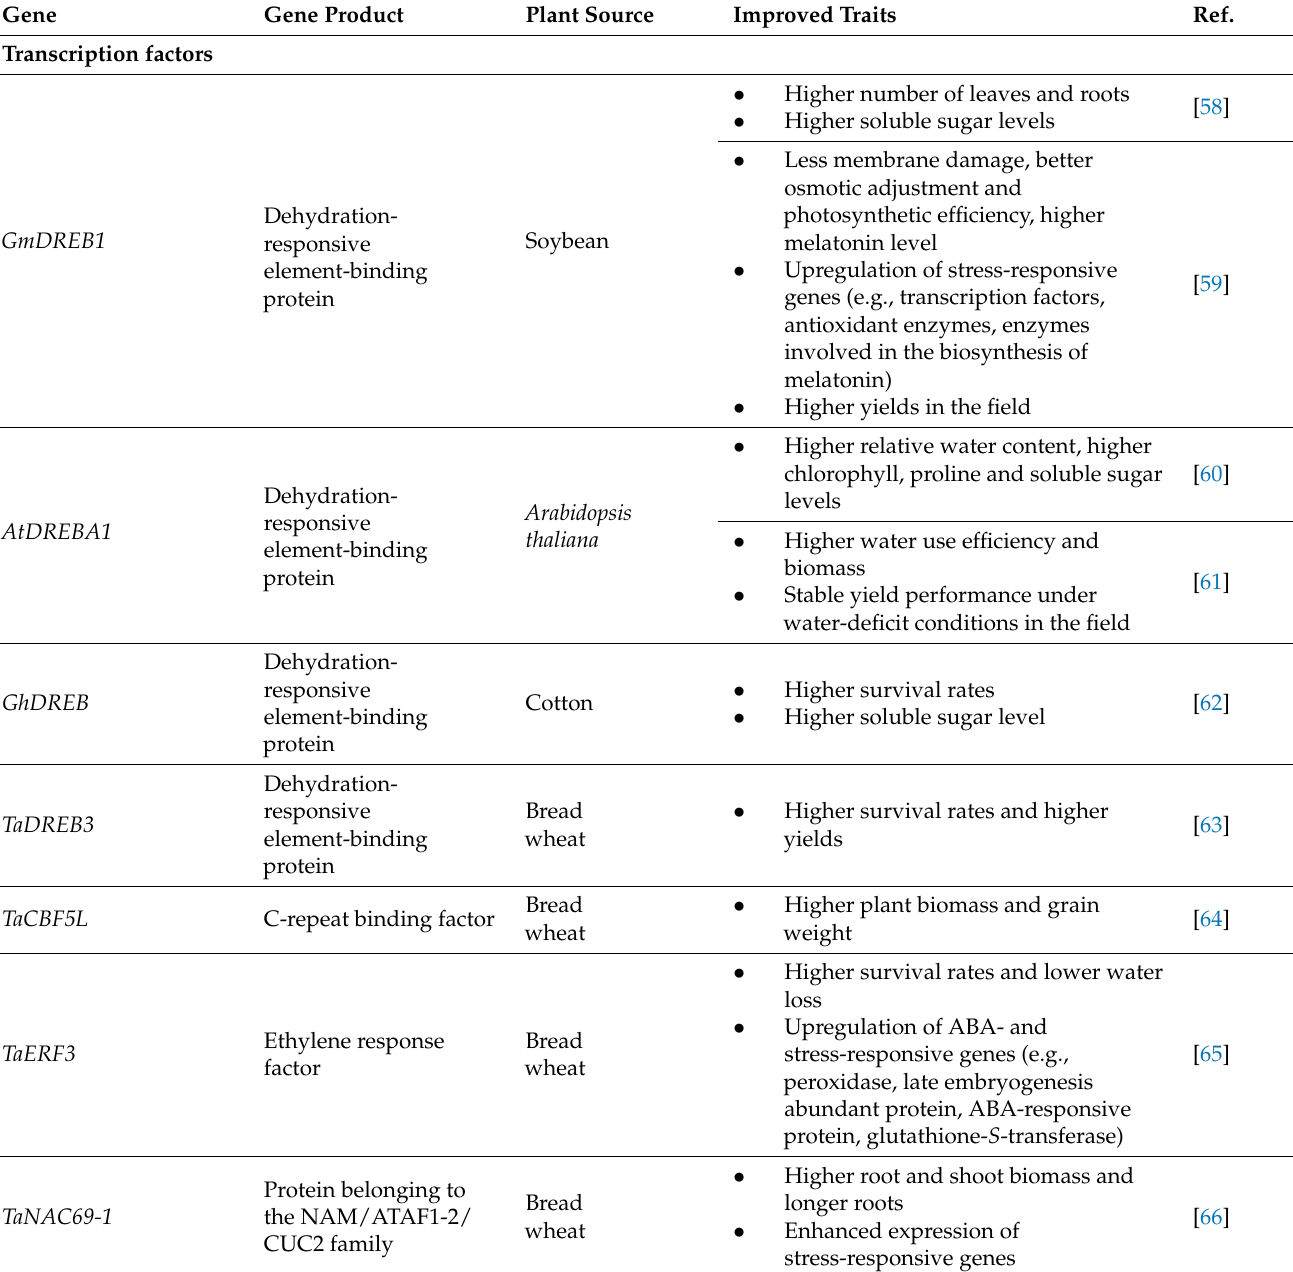
Table 1. Improvement of drought tolerance in wheat plants through transgenic